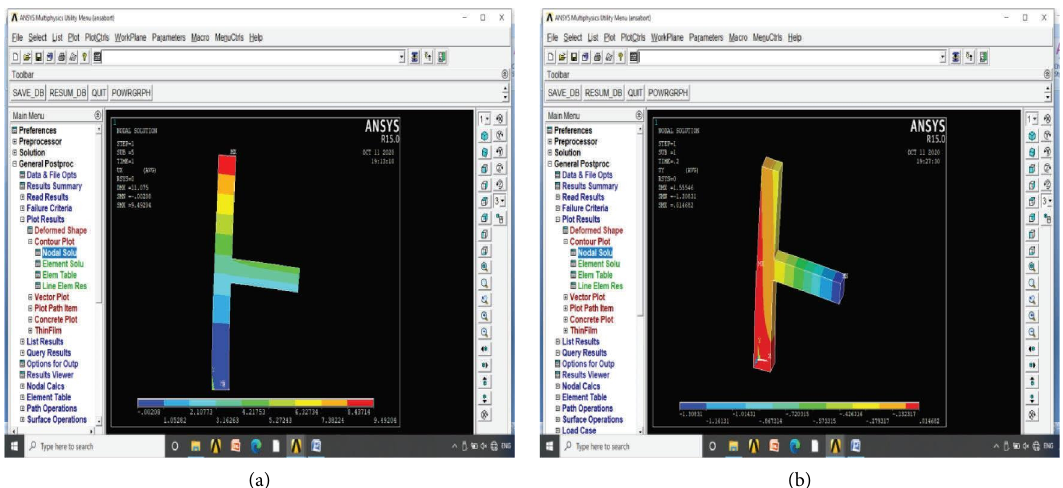
Figure 26: Typical ANSYS results: (a) control specimen and (b) SCC with Alccofne-10%